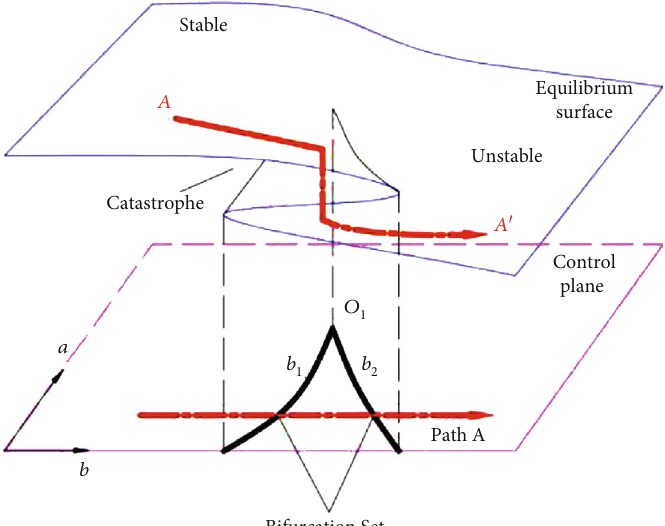
Figure 3: Cusp catastrophe model of coal